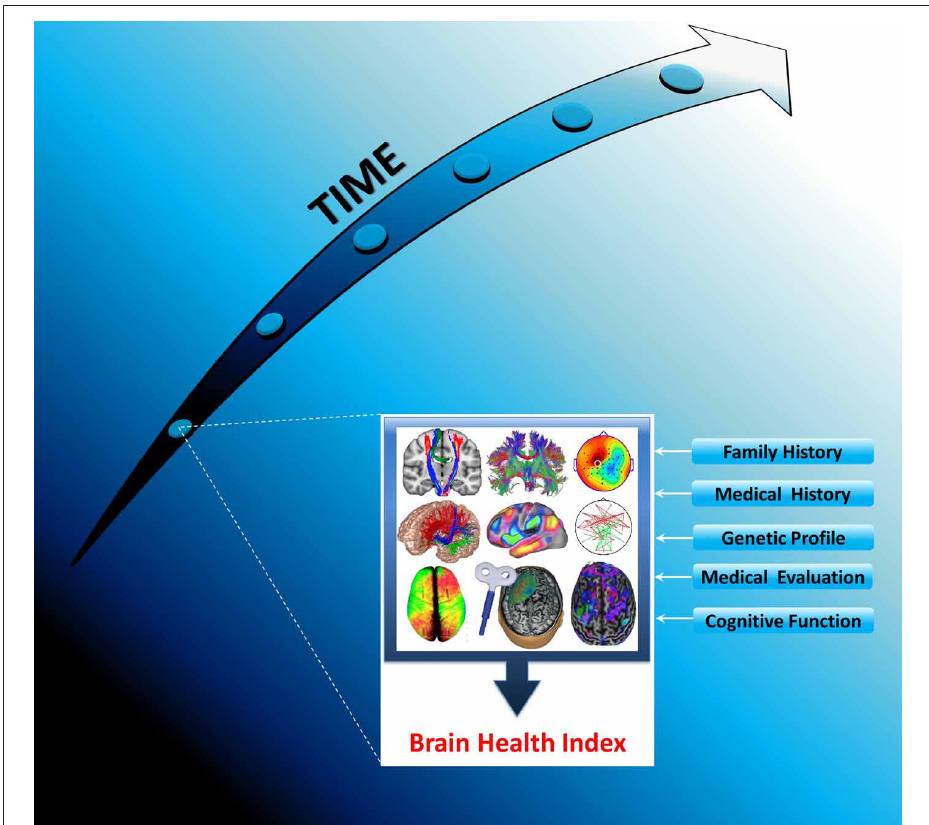
FIGURE 5 | Establishing a Brain Health Index (BHI): Schematic representation of the longitudinal monitoring of each individual’s BHI across the lifespan. The BHI includes neuronavigated, multimodal TMS measures suitable for identifying complex interactions between genes and environmental factors. Longitudinal monitoring of each individual’s BHI would allow the comparison of individual’s brain plasticity and network dynamics at every point in time to the previous history of that individual, thereby making it possible to identify pathological changes prior to manifestation of neuropsychiatric symptoms. To achieve this, the data gathered at the initial assessment and each follow-up, for each individual, will be added to a database to allow researchers to identify individual biomarkers for risk of disease with the ultimate goal of offering individualized, preventive interventions, and further monitor disease progression and treatment